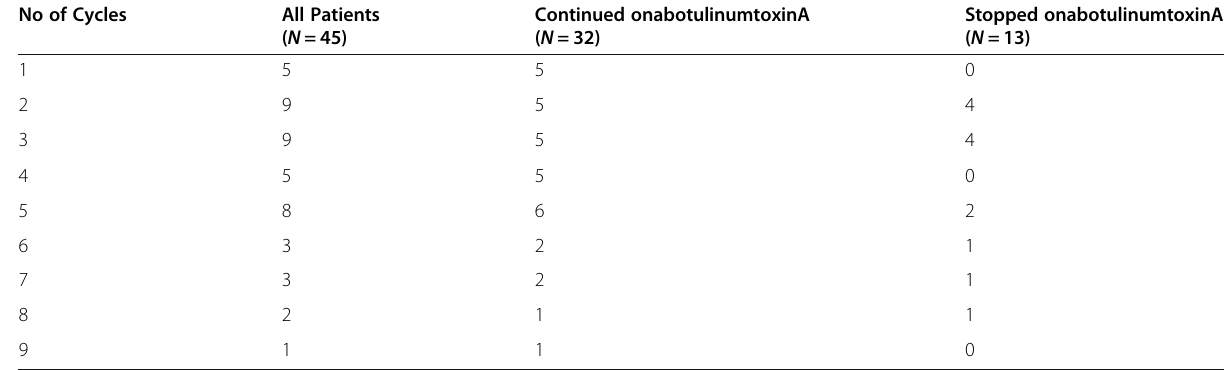
Table 2 No of cycles received before pregnancy No of Cycles All Patients ( N =